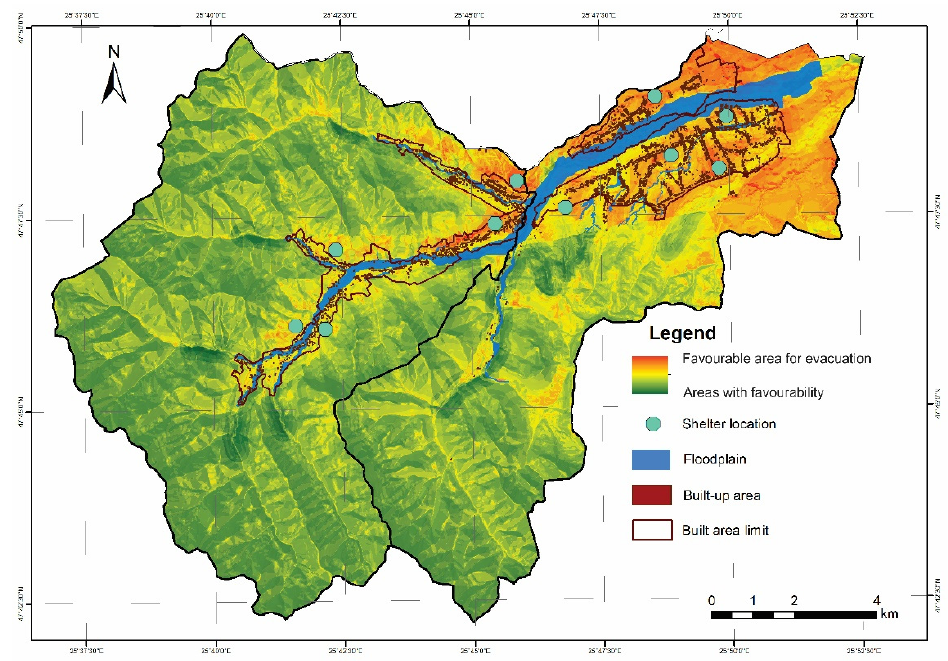
Figure 5. Population evacuation points established according to land favourability.